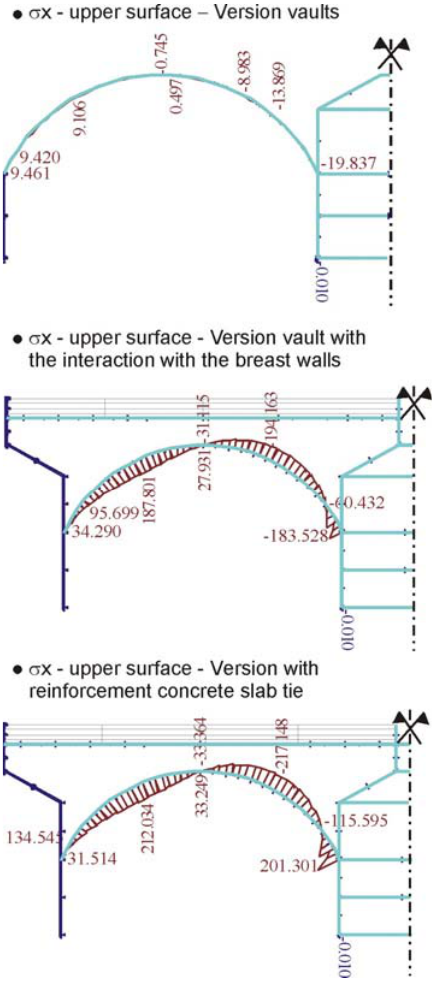
Fig 7. Comparison of normal stress σ x values in a charac- teristic cross-section of stone bridge structure